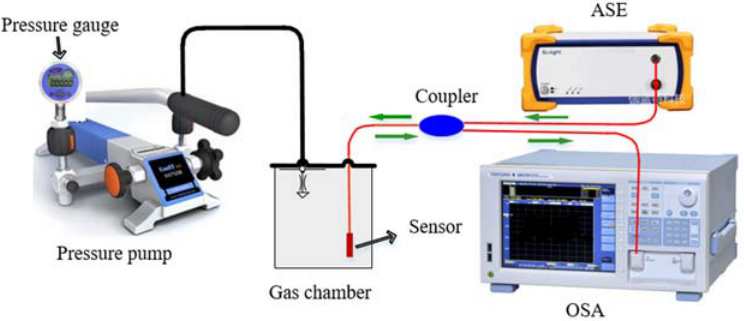
Figure 4. Experimental apparatus for the measure of gas pressure.